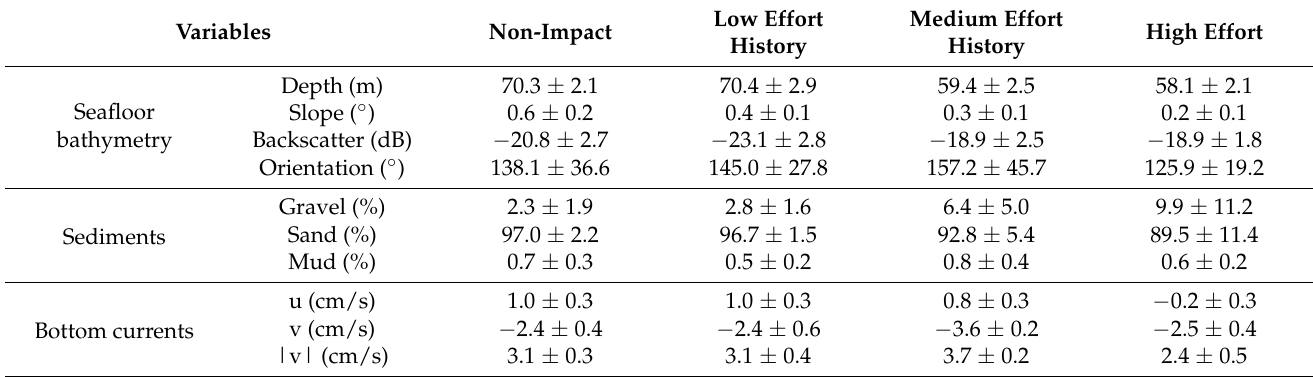
Table 1. Average values ( ± standard deviations) of environmental variables estimated on each of the four study areas with different levels of bottom trawl fishing effort at the SCI Menorca Channel (Balearic Islands, western Mediterranean). u and v are the horizontal and vertical components of velocity currents, respectively, and |v| is the velocity